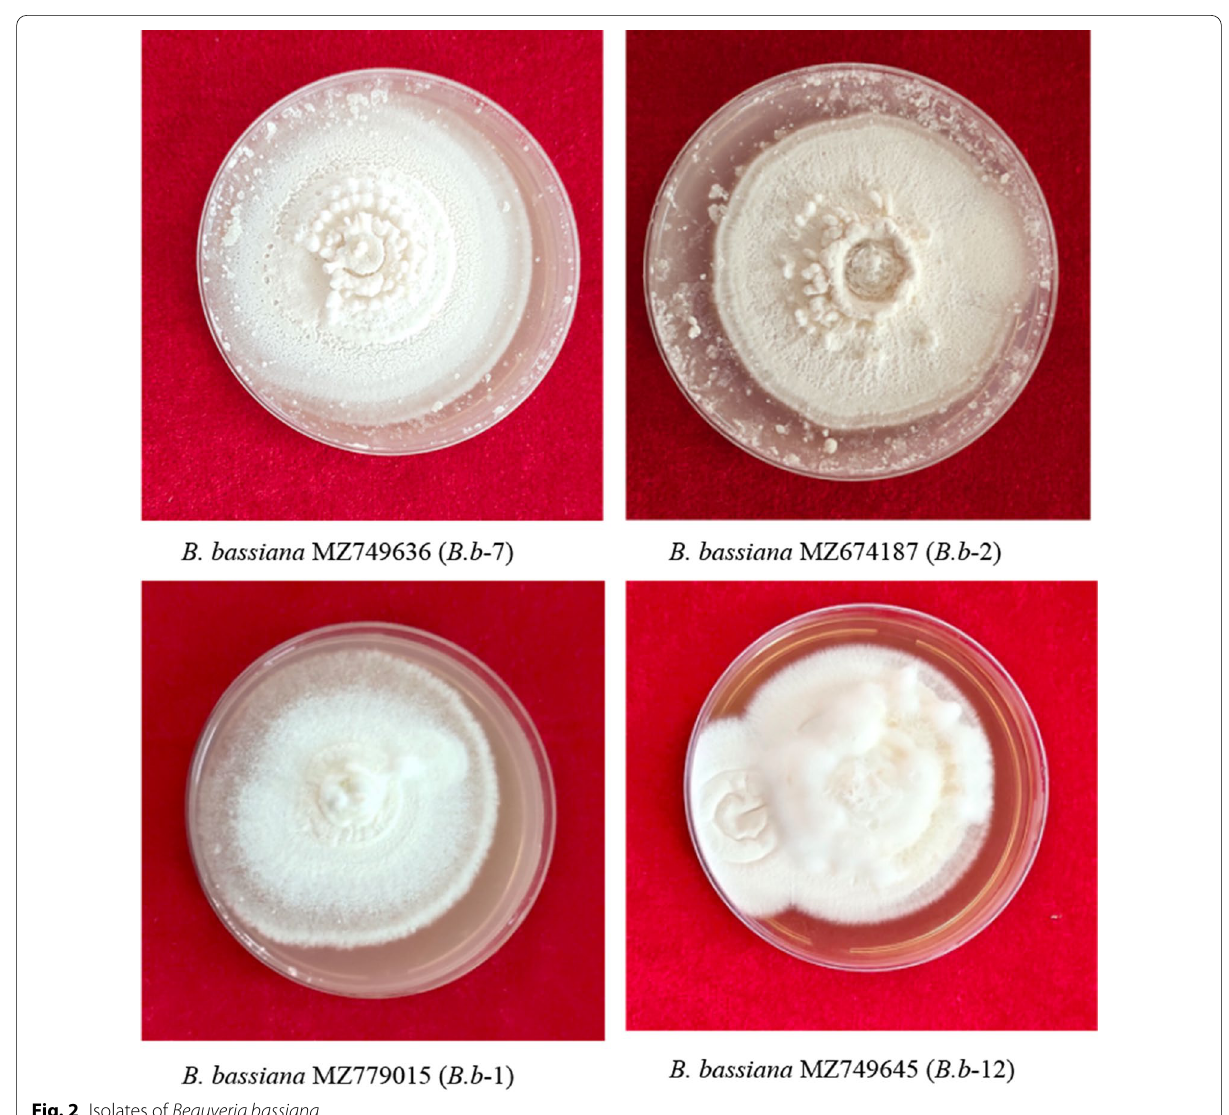
Fig. 2 Isolates of Beauveria bassiana